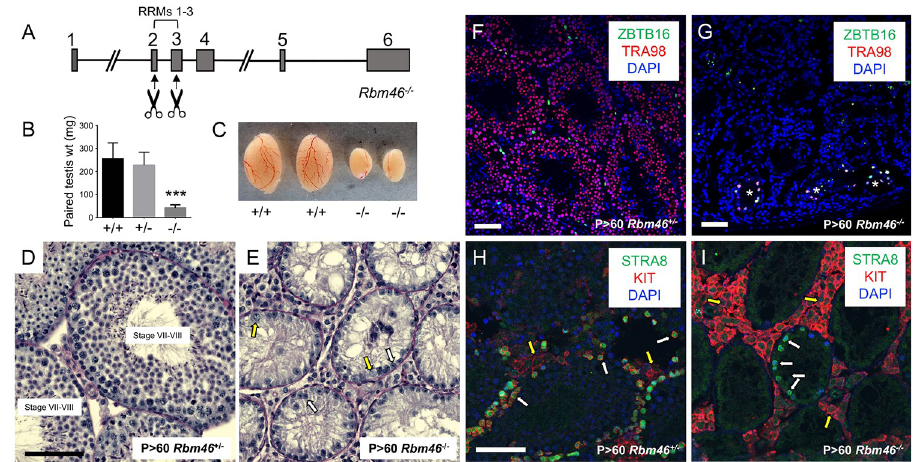
Fig 2. Adult Rbm46 -/- testes were dramatically reduced in size and contained only spermatogonia. ( A ) Diagram showing the genomic Rbm46 locus and the cut sites for deletion within exons 2–3. ( B-C ) Testes from Rbm46 -/- mice were significantly smaller than those from Rbm46 +/+ littermate controls. ( D-E ) PAS-stained Bouin’s-fixed testes from adult Rbm46 +/- ( D ) and Rbm46 -/- ( E ) mice, respectively. In contrast to control ( D ), Rbm46 -/- seminiferous epithelia ( E ) exhibited a single cellular layer, which included apparent Sertoli cells (white arrows) and spermatogonia (yellow arrows). ( F-I ) IIF was done to confirm the cellular identity of remaining cells in Rbm46 -/- seminiferous epithelia. Compared to controls ( F ), Rbm46 -/- seminiferous epithelia ( G ) contained ZBTB16+ (green) undifferentiated spermatogonia (in tubules marked with an asterisk), and germ cells were immunostained for the pan germ cell marker TRA98 (red). Compared to controls ( H ), some spermatogonia (indicated by white arrows) in Rbm46 -/- testes were STRA8+ (green, I ), indicating response to RA, but none were KIT+ (red, I ), revealing impaired differentiation. Interstitial cells (marked by yellow arrows, shown in H-I ) are always KIT+. Nuclei were stained with DAPI (blue). Triple asterisks indicate statistical significance at P < 0.001. Scale bars = 50 μ m.